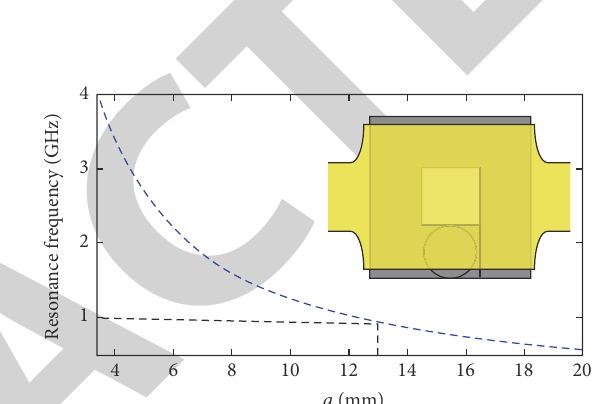
Figure 1: (a) 3D layout of the DNG cell including quasi-planar chiral resonator (particle) electrically loaded to a microstrip line with series gaps. (b) Lumped element equivalent circuit and equivalent T-model.